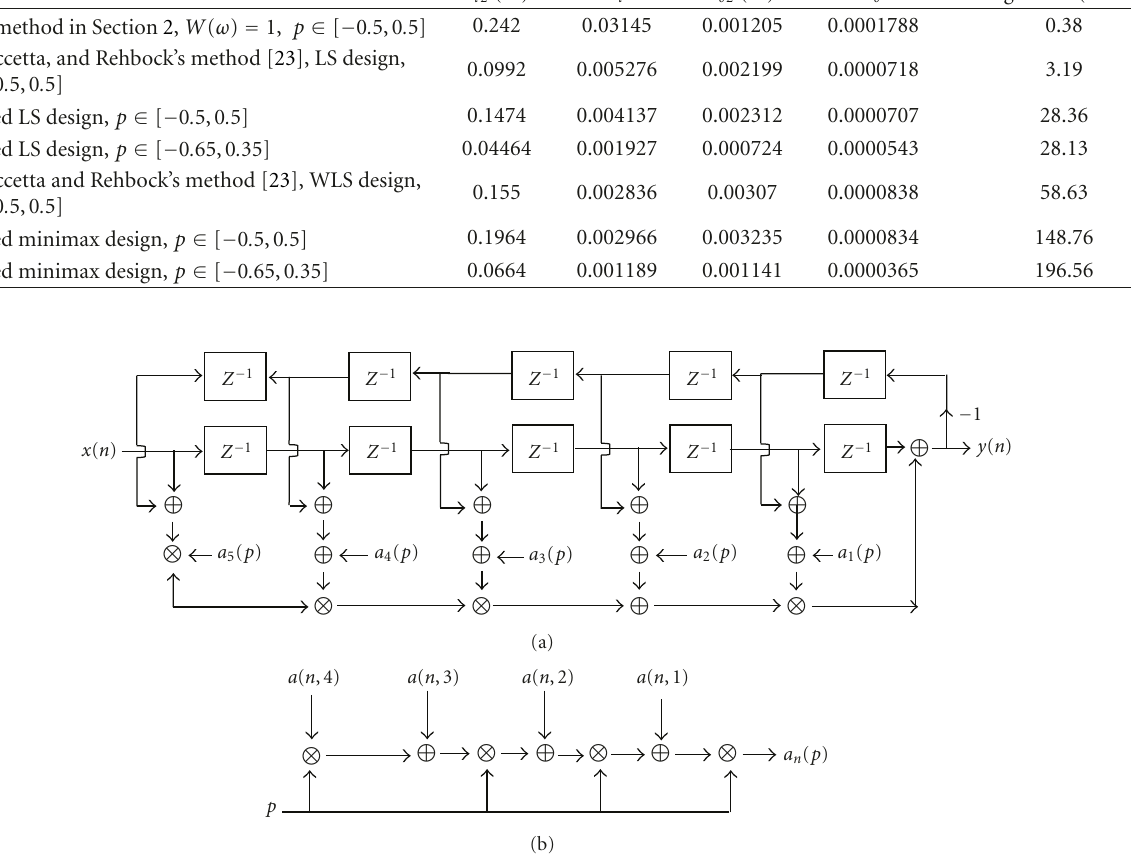
Figure 1: (a) The proposed structure of an allpass VFD digital filter ( N = 5, M = 4). (b) Coe ffi cient generator (1 ≤ n ≤ 5).